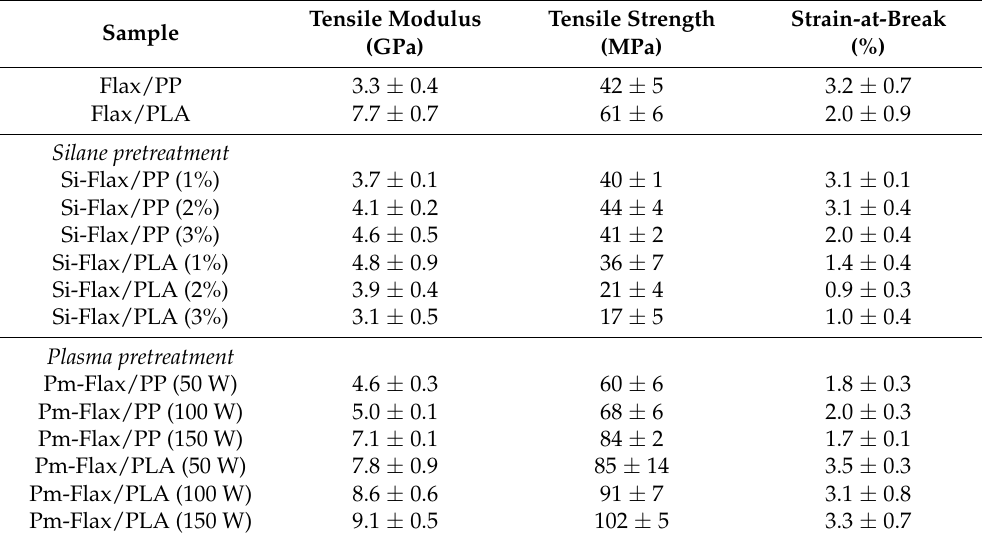
Figure 2. Stress–strain curves of ( a , b ) Flax/PP and ( c , d ) Flax/PLA single layered laminates from the fabrics treated with ( a , c ) silane at different concentrations and ( b , d ) atmospheric plasma with different plasma flame intensities. Table 4. Tensile properties of single-layered laminates from non-FR fabrics pretreated with either silane or